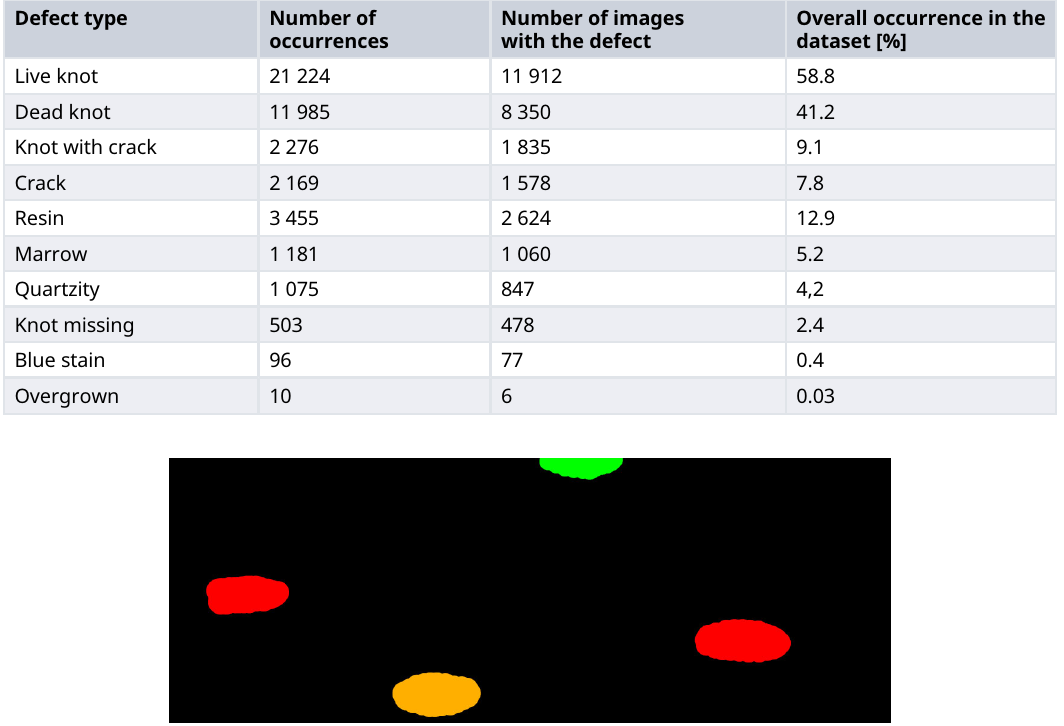
Figure 5. Example of a semantic segmentation label. The red label represents dead knots, the green label stands for live knots, and the dark yellow represents knots with cracks.